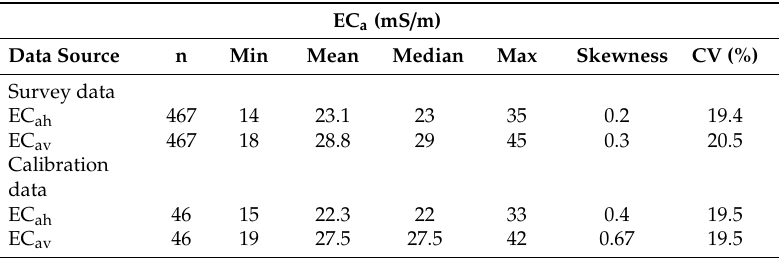
Table 3. Summary statistics of apparent electrical conductivity (EC a mS / m) measured by an EM38 instrument for the entire survey area and at the 46 calibration points.